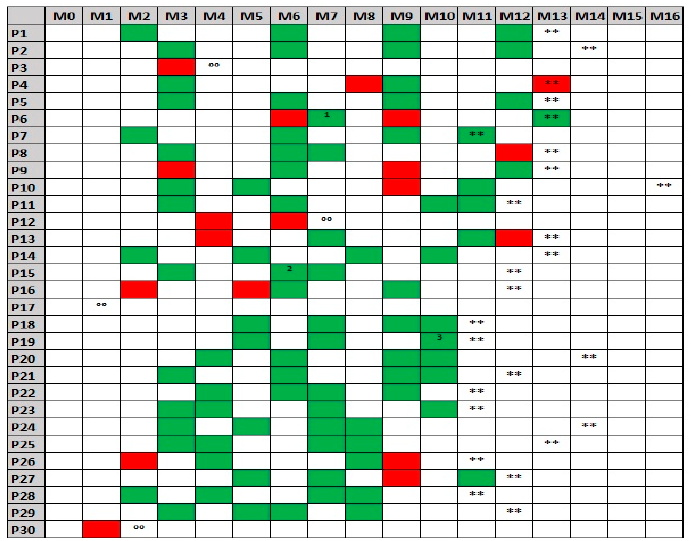
Figure 1. Timeline of study visits for each participant of the intervention group. M: month, P: patient. ** close out visit, ◦◦ drop-out. Successful teleconsultations are indicated in green, unsuccessful attempts in red. Corrections: 1 the successful teleconsultation was performed at M6, 2 two successful teleconsultations were performed at M6, 3 two successful teleconsultations were performed at M10.